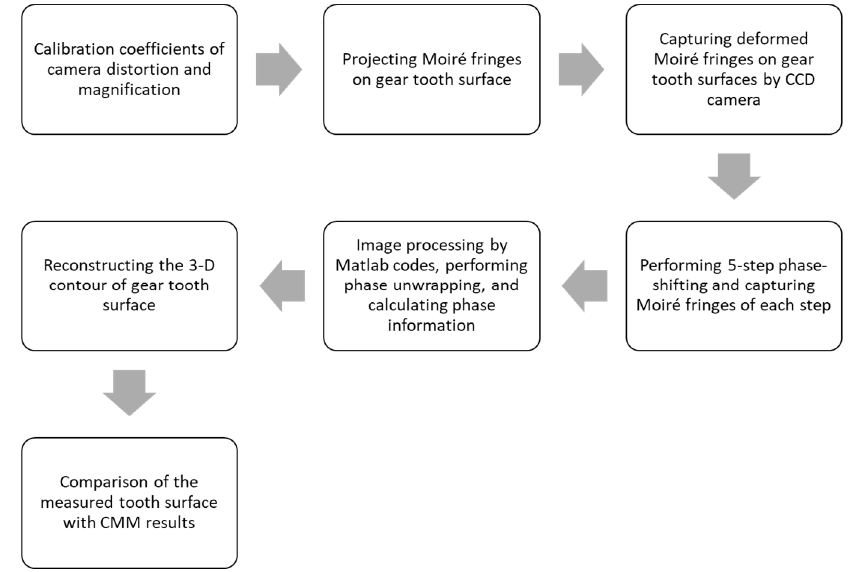
Figure 5. Process of the proposed optical inspection of the gear tooth surface.